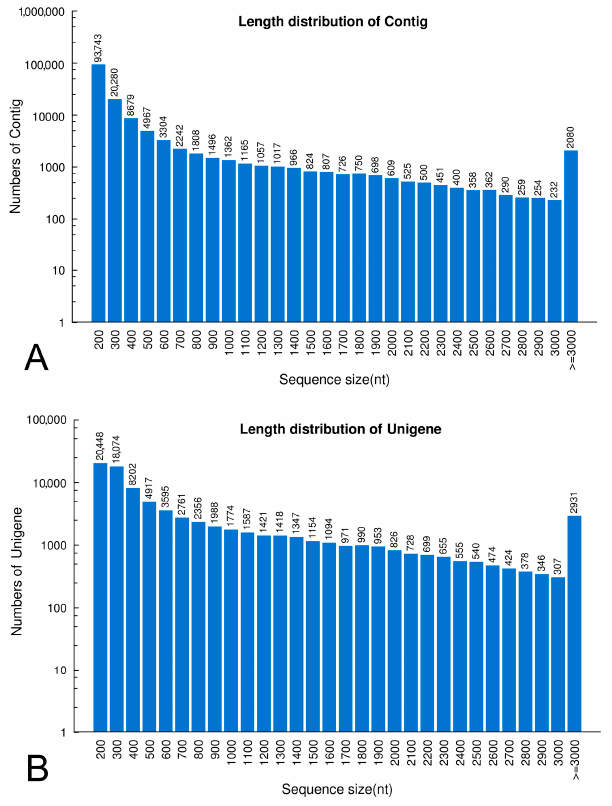
Figure 1. Sequence length distribution of contigs ( A ) and unigenes ( B ).